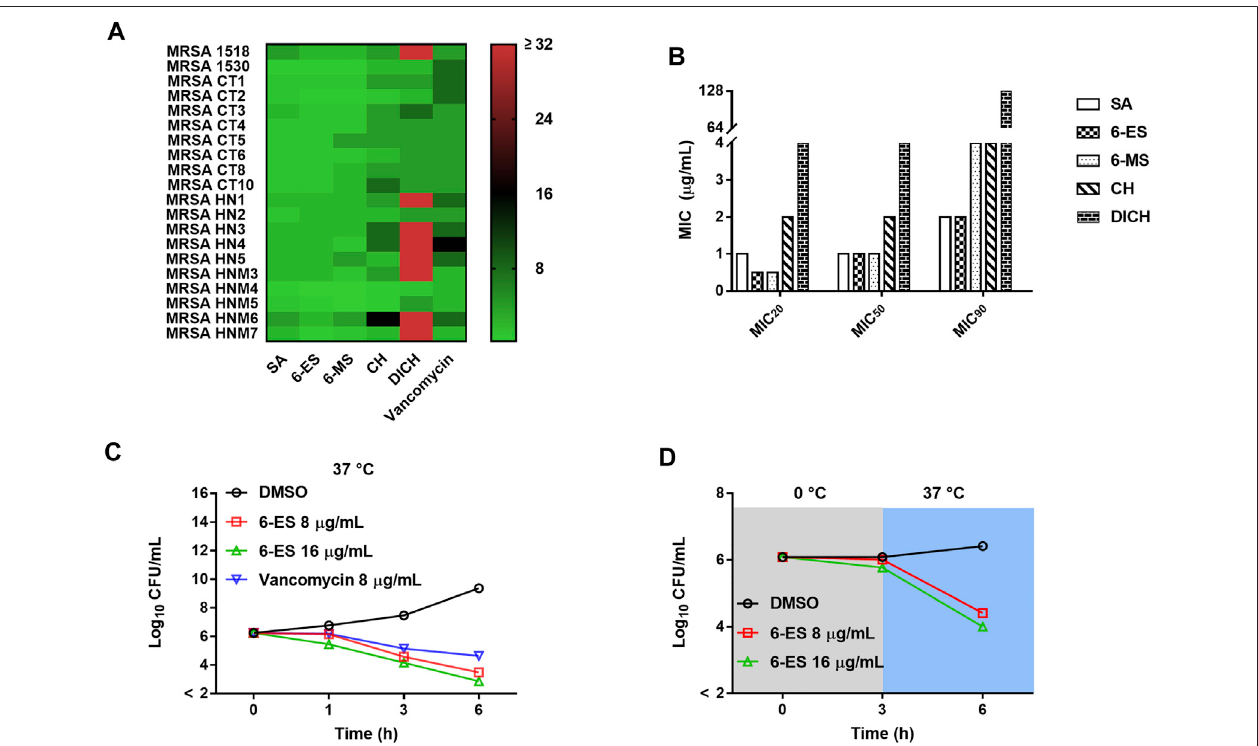
FIGURE 1 | Antibacterial effects of SA, 6-ES, 6-MS, CH, and DICH against MRSA. (A) Heat map of the MICs of SA, 6-ES, 6-MS, CH, and DICH against MRSA strains. (B) MIC 20 , MIC 50 and MIC 90 of SA, 6-ES, 6-MS, CH, and DICH against MRSA strains. (C) MRSA T144 cells were cultured with 6-ES at 37 ° C, and the surviving bacteria were determined with the plate method at the indicated times. (D) Bactericidal activity of 6-ES against MRSA T144 at 0 and 37 °